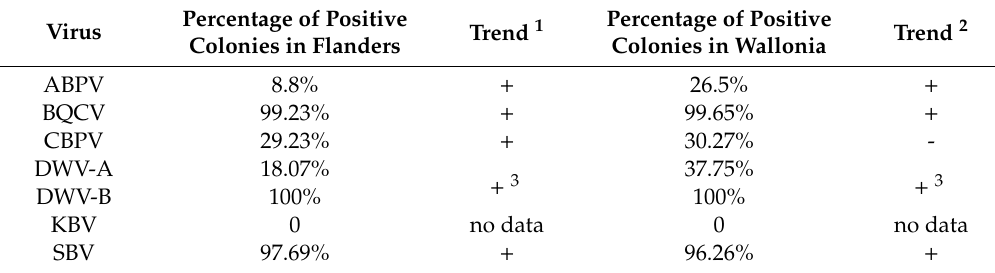
Table 3. Percentages of positive colonies per virus in honey bee colonies from Flanders and Wallonia and indications of increase ( + ) or decrease (-) compared to previous studies.